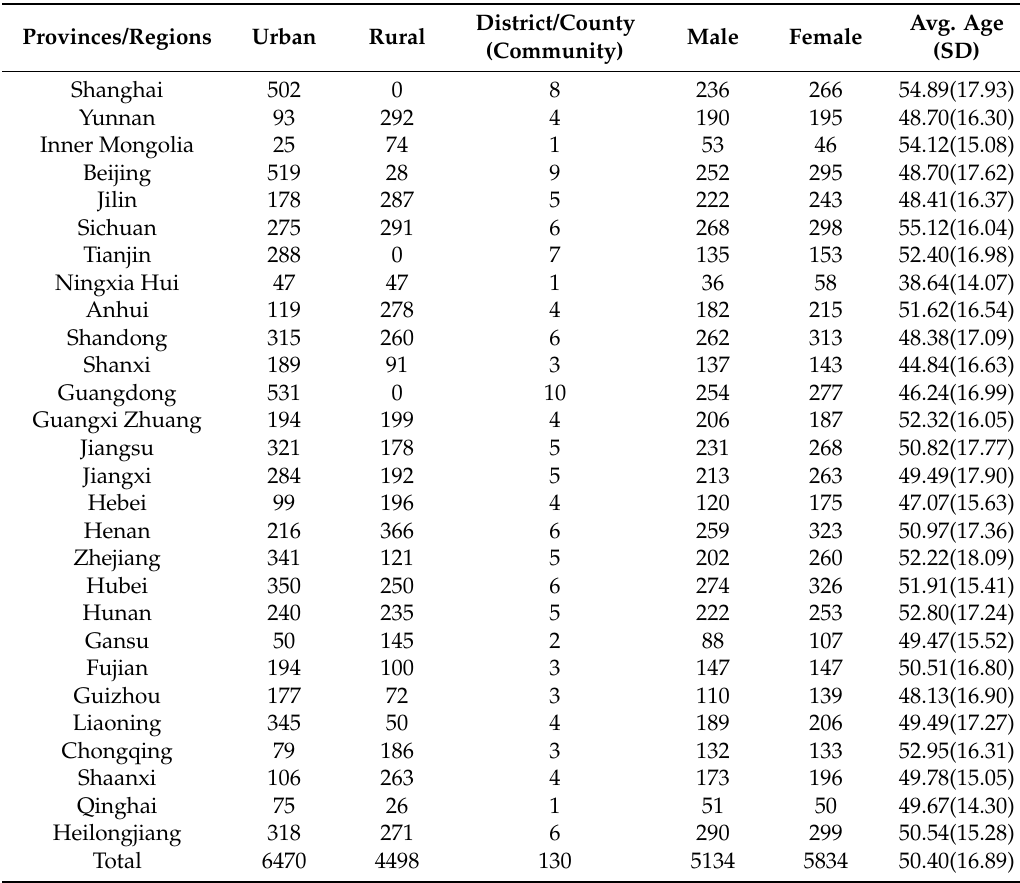
Table 1. Descriptions of the